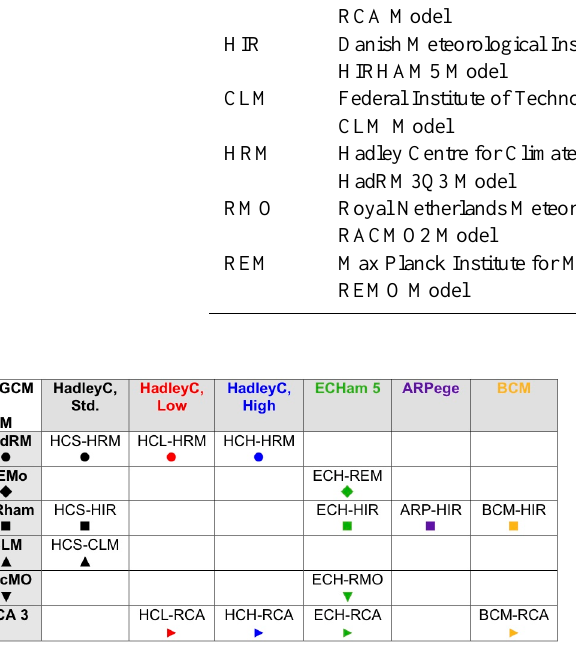
Fig. 2. Combinations of Global Climate Models (GCMs) and Regional Climate Models (RCMs) considered in this study. In all figures, we use the same color (symbol) to refer to the same GCM (RCM). Model acronyms are introduced in Tables 2 and 3.